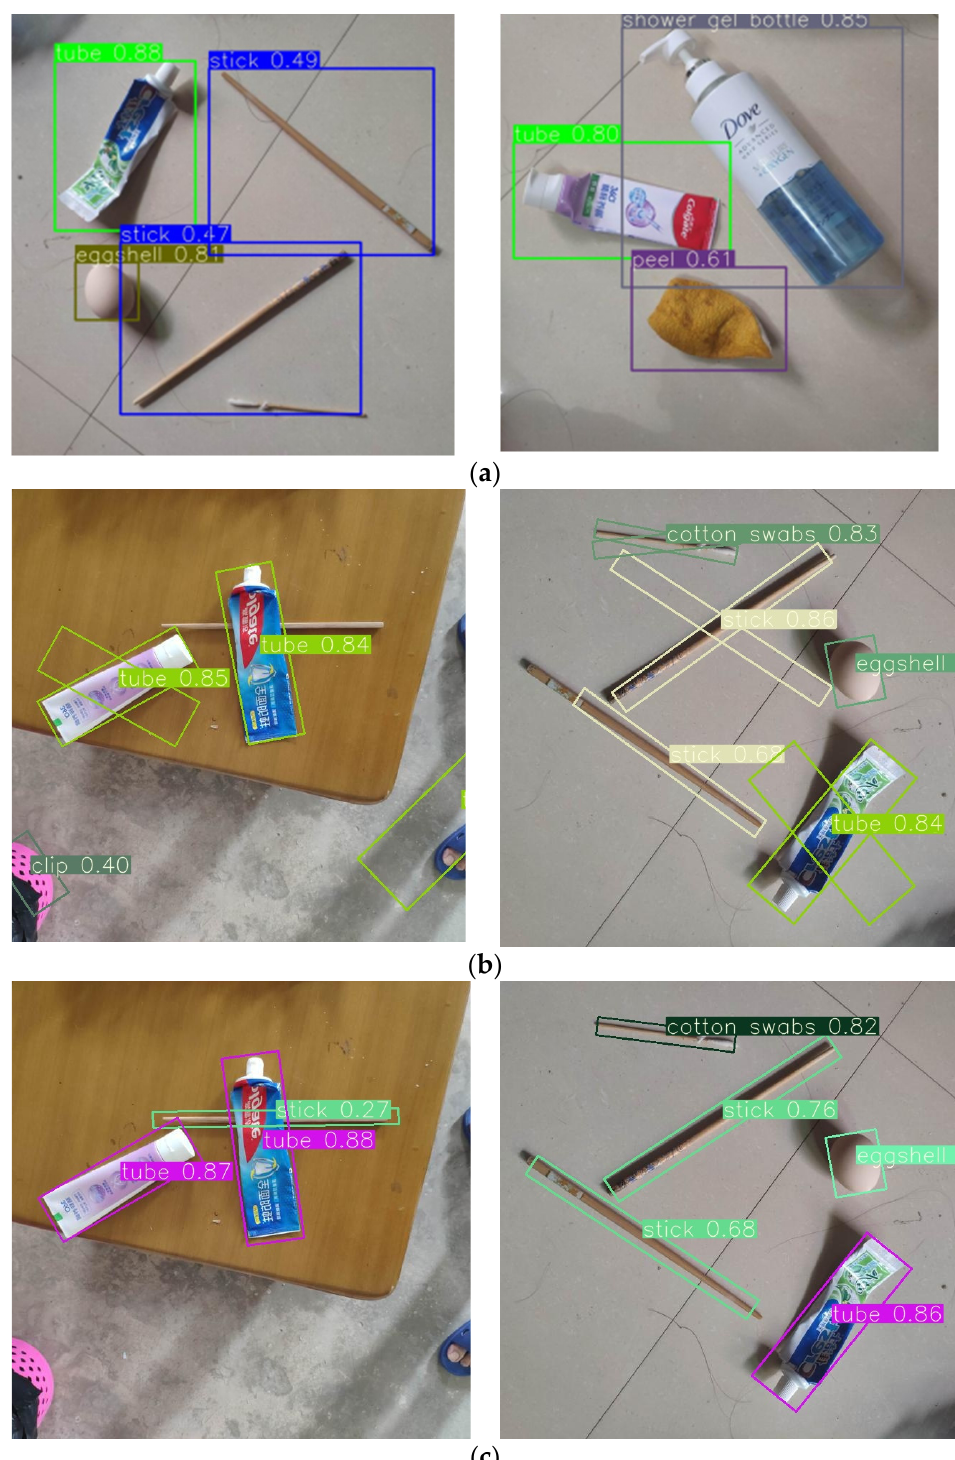
Figure 10. Comparison of detection effects of the methods. ( a ) Detection using YOLOv5m. ( b ) De- tection using YOLOv5m-OBB. ( c ) Detection using YOLOv5m-DSM.